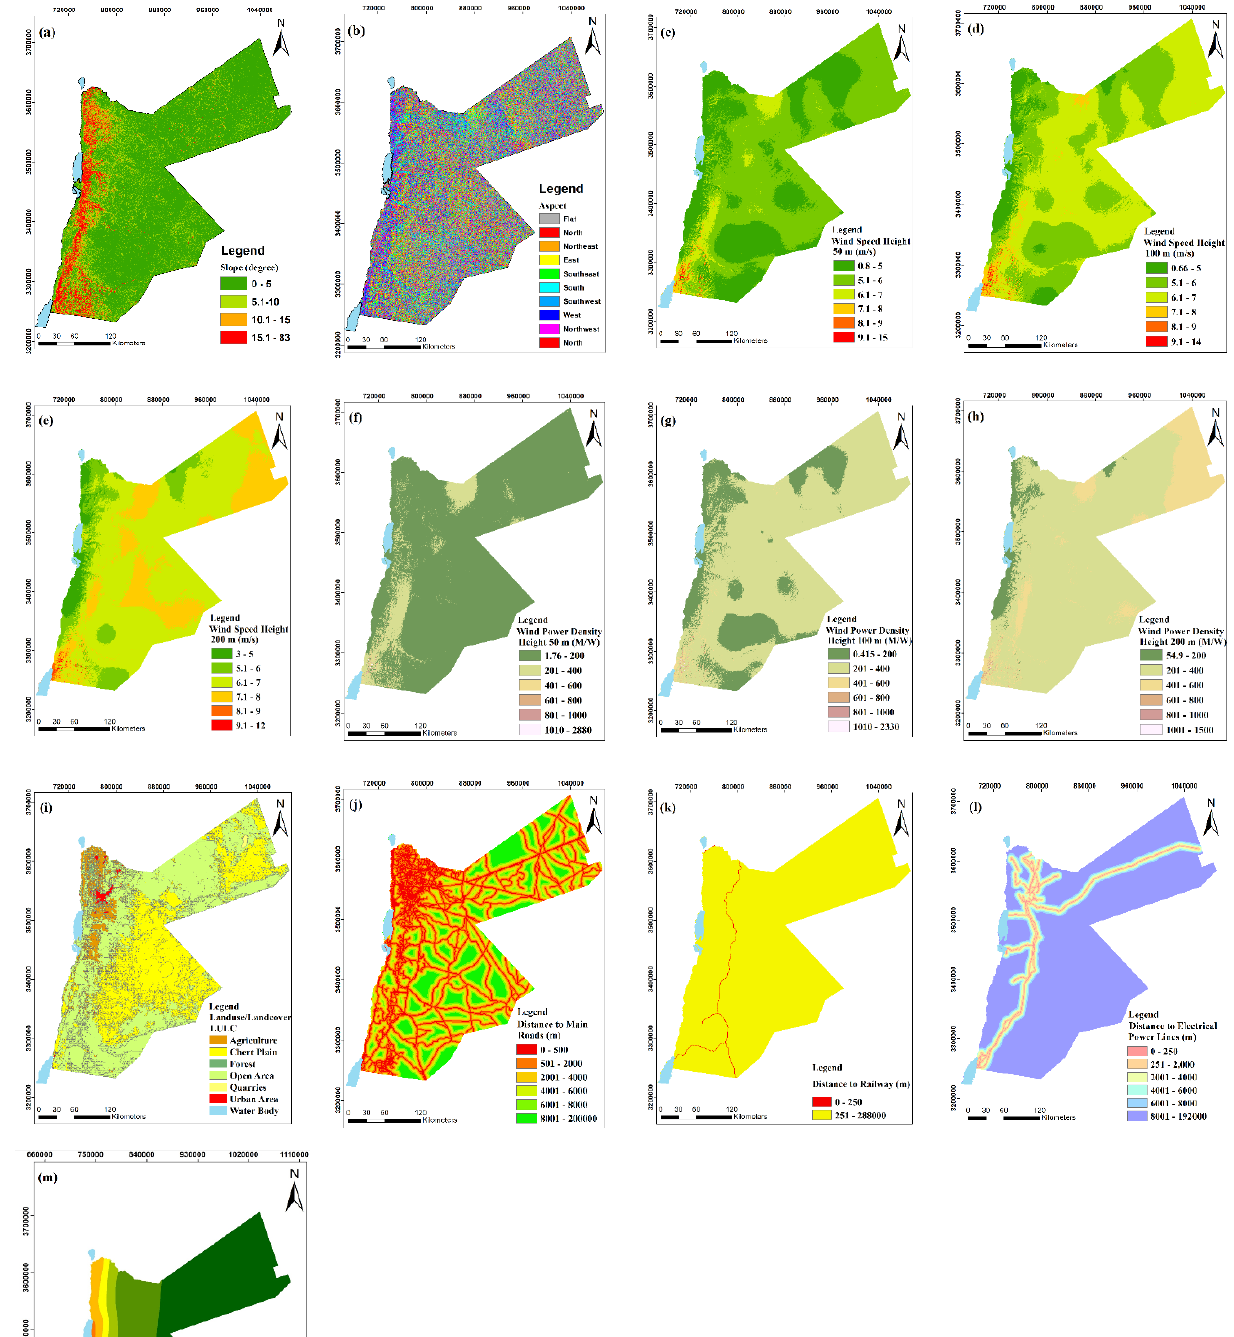
Figure 2. Base maps of Jordan containing necessary information layer inputs; ( a ) Slope Map, ( b ) Aspect Map, ( c ) Wind Speed (m/s) at a height of 50 m Map, ( d ) Wind Speed (m/s) at a height of 100 m Map, ( e ) Wind Speed (m/s) at a height of 200 m Map, ( f ) Wind Power Density (W/m 2 ) at a height of 50 m Map, ( g ) Wind Power Density (W/m 2 ) at a height of 100 m Map, ( h ) Wind Power Density (W/m 2 ) at a height of 200 m Map, ( i ) land-use/landcover LULC Map, ( j ) Euclidean Distance Main Road Map, ( k ) Euclidean Distance Railway Map, ( l ) Main Electrical Power Lines Map, ( m ) Potential Earthquake Hazard